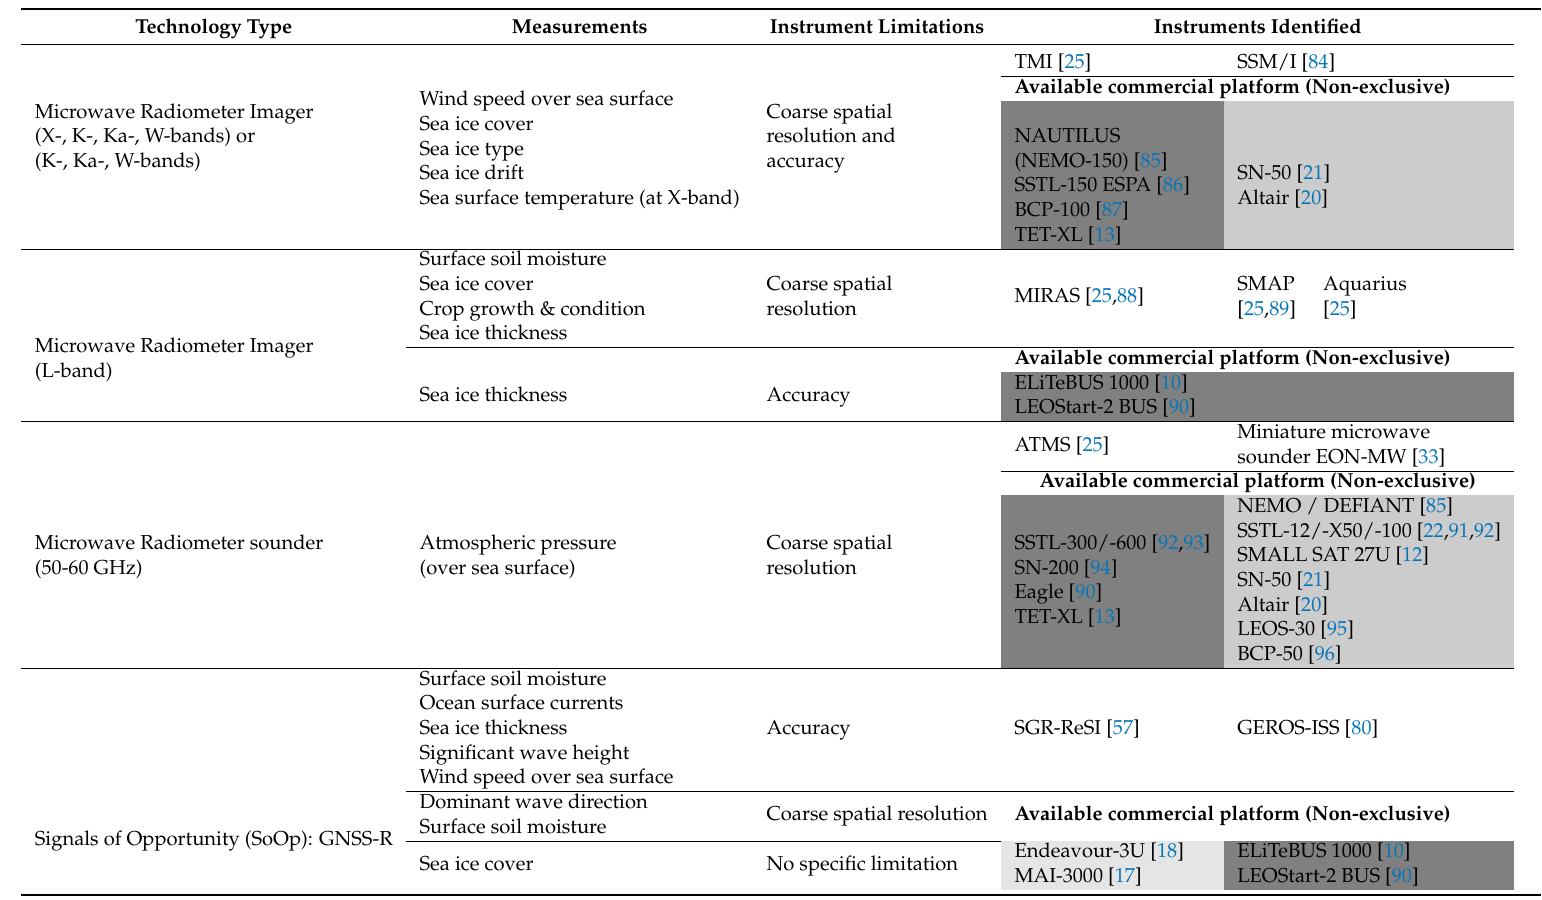
Table 6. Mapping of potential passive sensors and platforms to meet the user